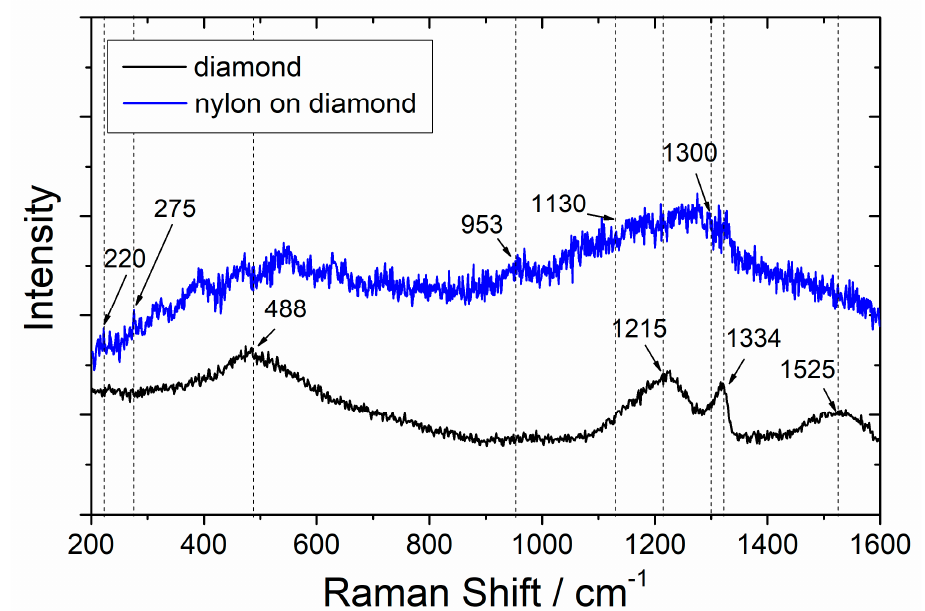
Figure 5. Comparison of Raman spectra for as-grown, boron-doped, diamond and nylon-coated diamond nanosheet. diamond